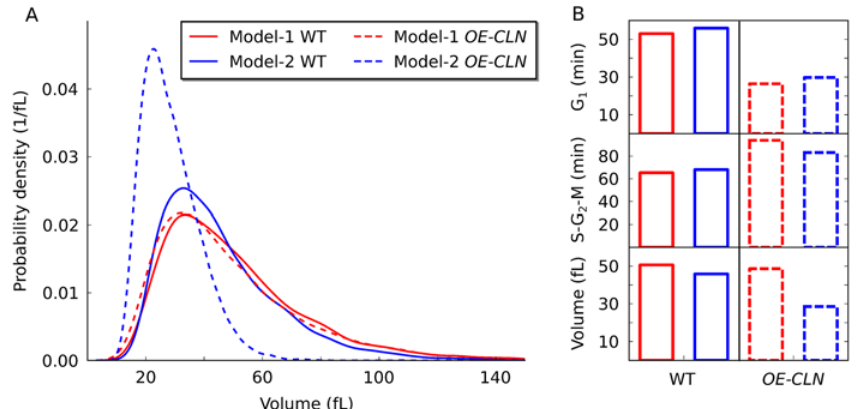
Fig 7. A bud sizer is required to predict the CLN overexpression mutant. (A) Cell size distributions are shown for the fast growing wild type (WT, solid lines) and CLN over producing mutant ( OE-CLN , dashed lines) simulated with Model-1 (red) and Model-2 (blue), corresponding to a CLN3 overexpression mutant in vivo . (B) Average length of G 1 , S-G 2 -M and average cell volume are shown for the wild type (solid bars) and OE-CLN cells (dashed bars) simulated with Model-1 (red) and Model-2 (blue).